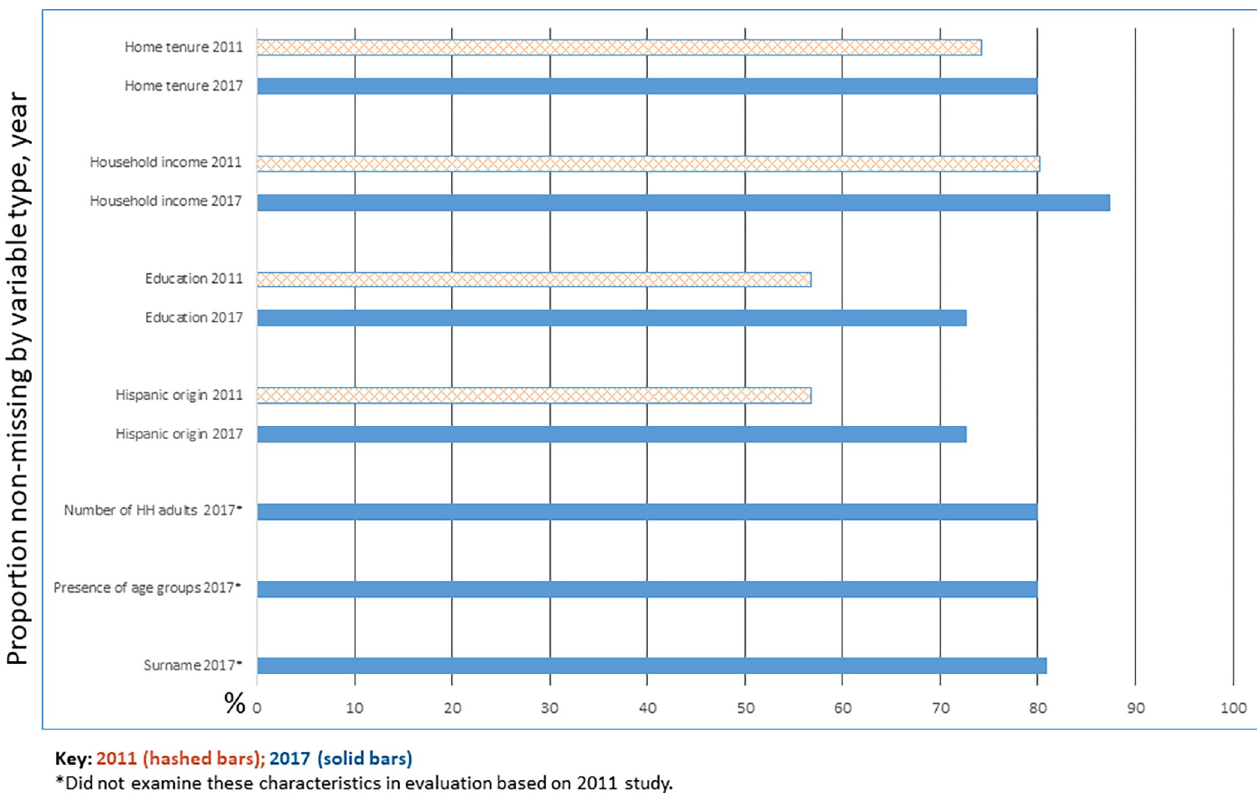
Fig 1. Non-missing rate for appended